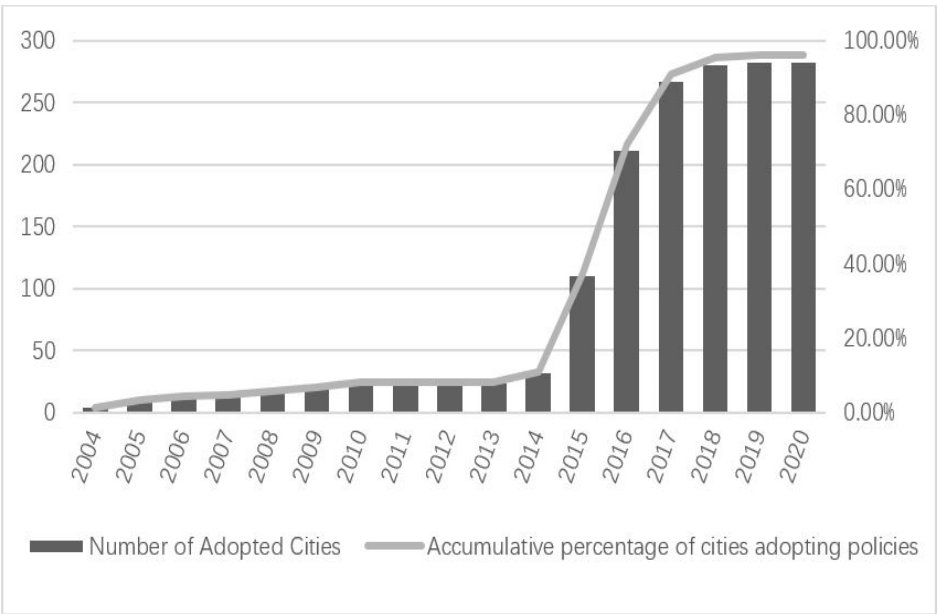
Figure 1. Diffusion of PPP policy in prefecture-level cities in China.